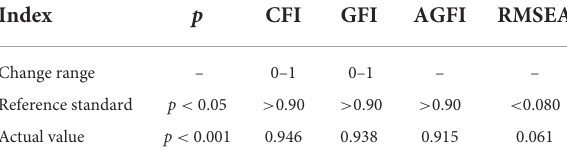
TABLE 2 Acculturation and Family support of the MEFC.